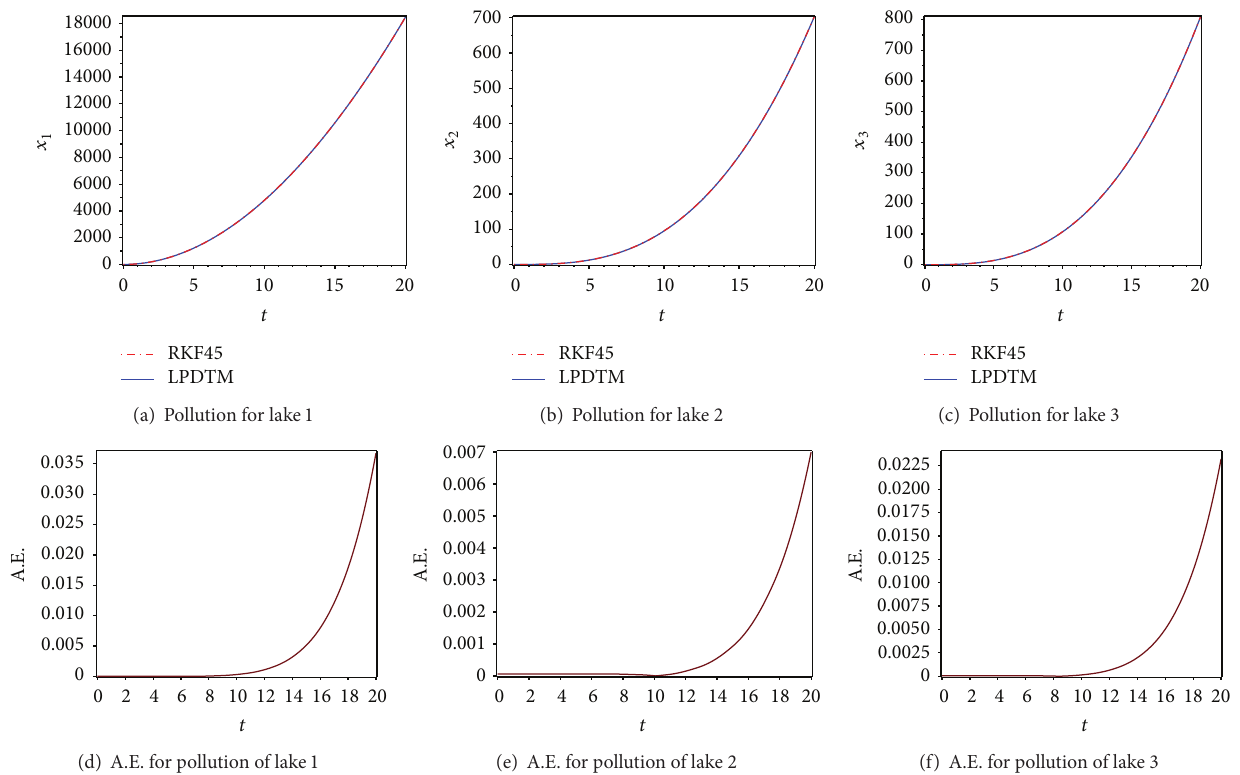
Figure 4: Linear input signal and absolute error (A.E.) of approximations. The time 𝑡 is expressed in